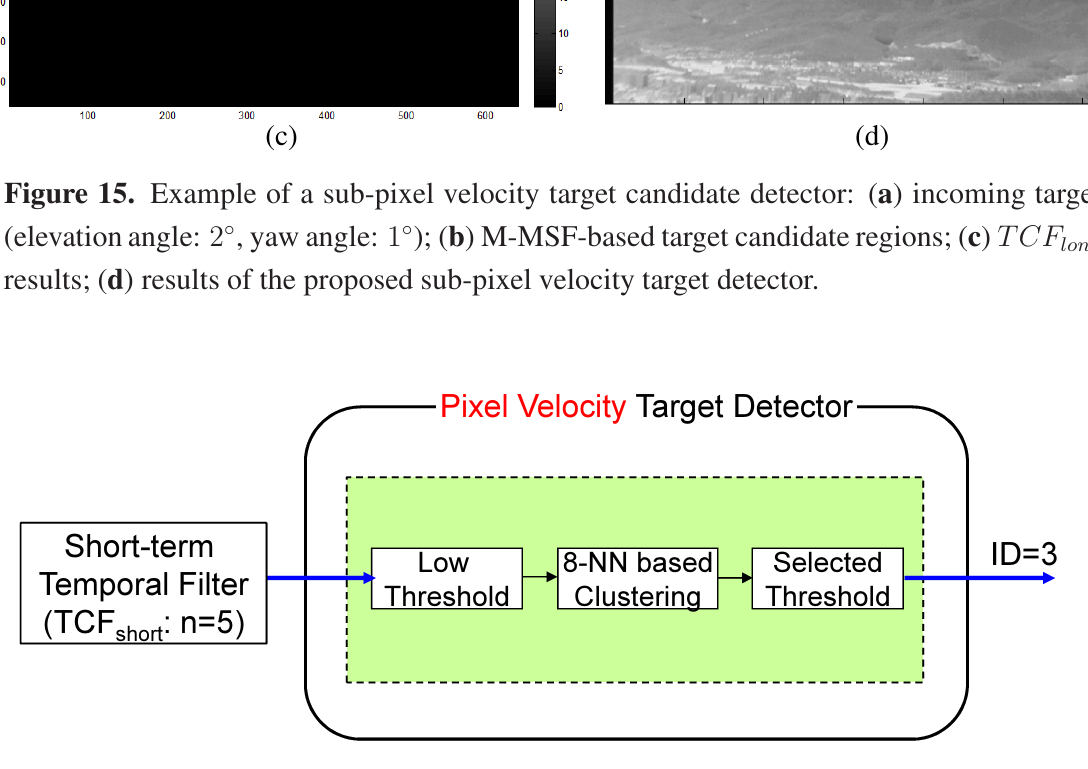
Figure 16. Pixel velocity target candidate detector: fast moving (pixel velocity) targets are detected using the short-term TCF and hysteresis